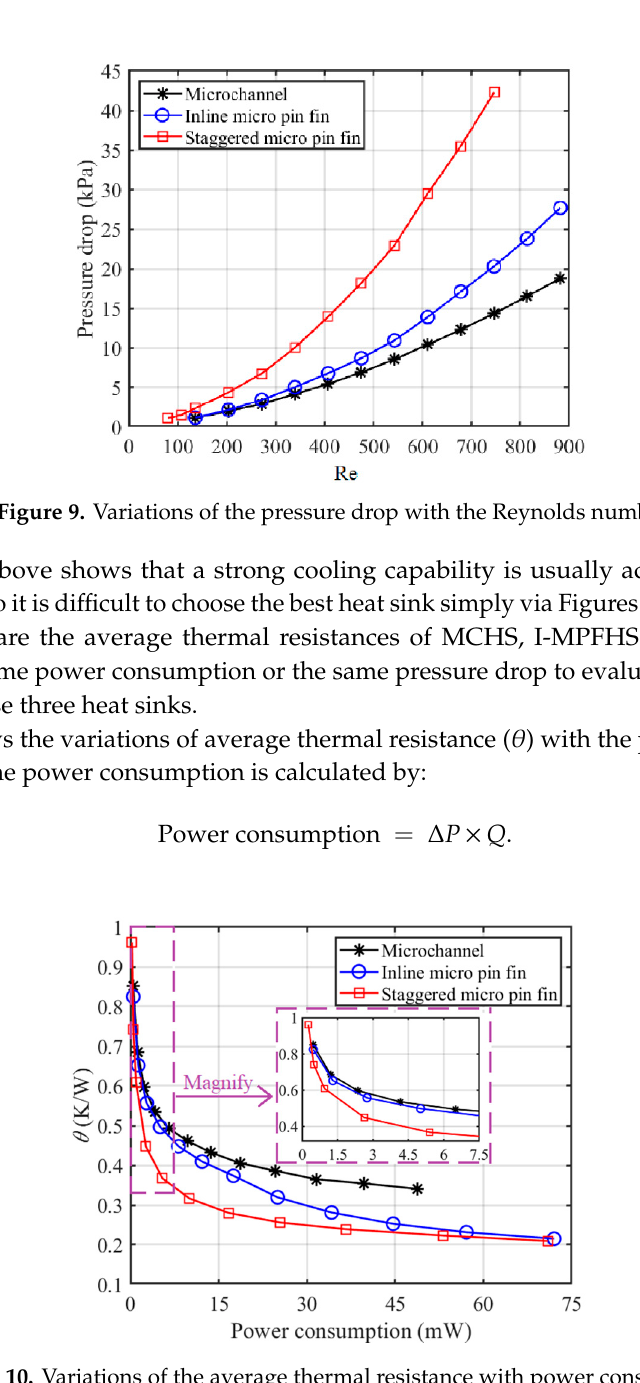
resistance and the pressure drop of the heat sink is dominated by friction resistance at low Re, so that